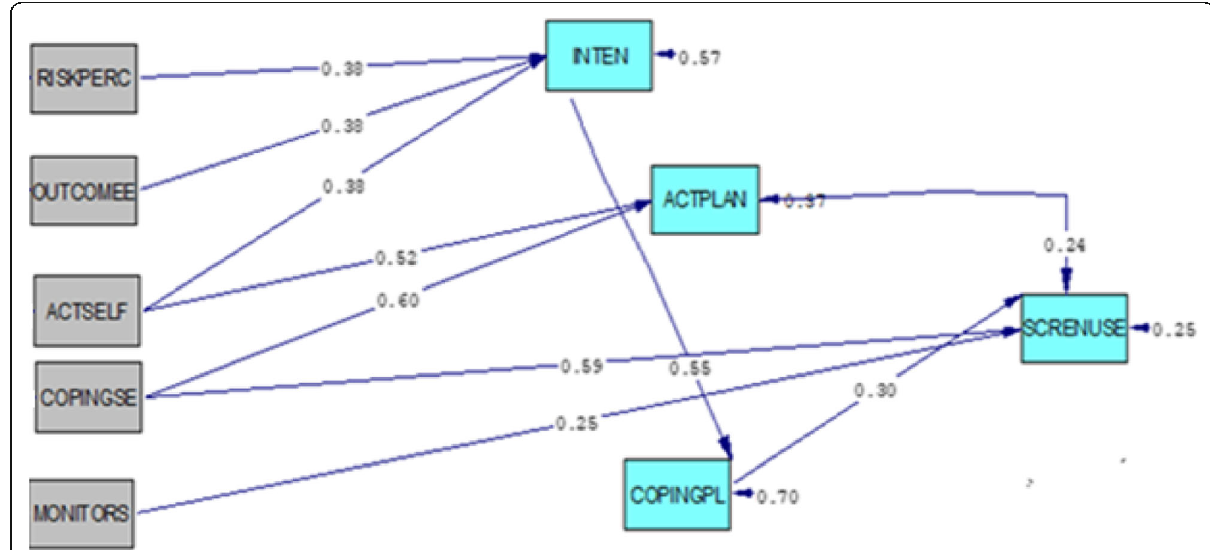
Fig. 2 Final path analysis model. RISKPERC: Risk Perception; OUTCOMEE: Outcome Expectation; ACTSELF: Action Self Efficacy; COPINGSE; Coping Self-Efficacy; MONITORS: Self – Monitoring; INTEN: Intention; ACTPLAN: Action Planning; CSE: Coping Planning; SCRENUSE: Sun Screen